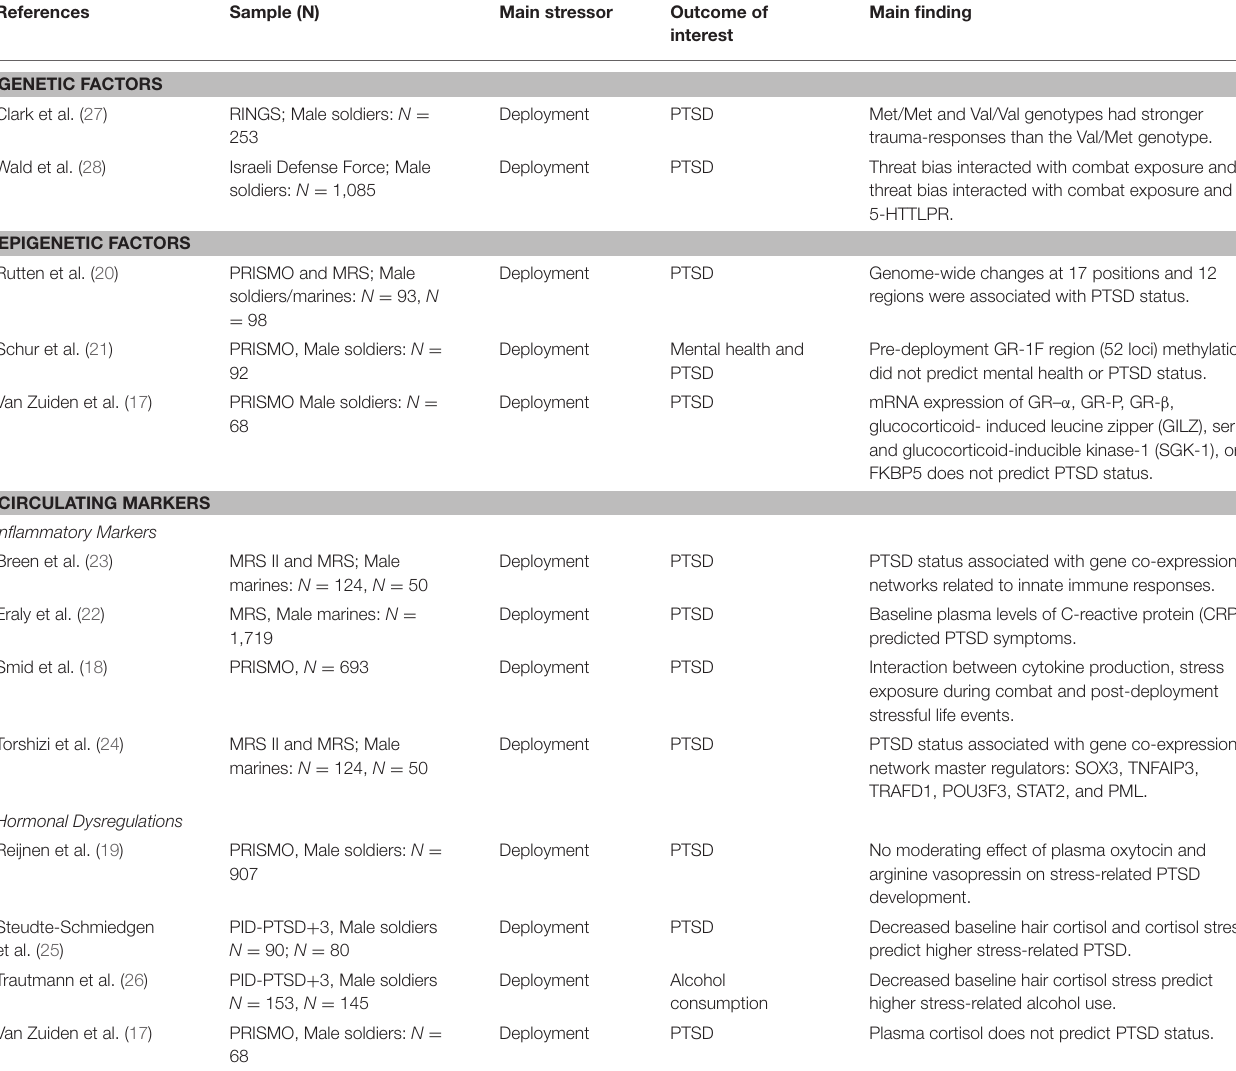
TABLE 2 | Longitudinal human studies assessing biological outcomes associated with differential susceptibility to